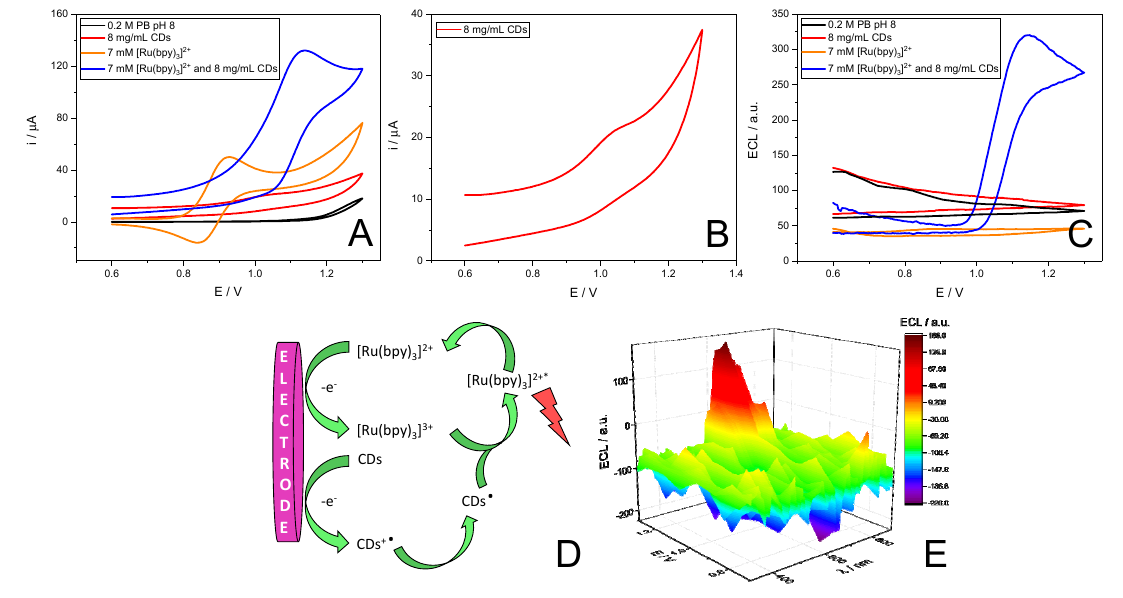
Figure 1. ( A ) Cyclic voltammograms and ( B ) magnification of the CD cyclic voltammogram. ( C ) ECL signals of a CSPE in a solution of: electrolyte (0.2 M PB pH 8) (black line), 8 mg/mL CDs (red line), 7 mM [Ru(bpy) 3 ] 2+ (orange line) and 7 mM [Ru(bpy) 3 ] 2+ with 8 mg/mL CDs (blue line) in 0.2 M PB pH 8. ( D ) Proposed mechanism for the [Ru(bpy) 3 ] 3+ /CD system. ( E ) 3D ECL spectrum of [Ru(bpy) 3 ] 2+ /CD system. These measurements were performed using 0.2 M PB pH 8 as electrolyte